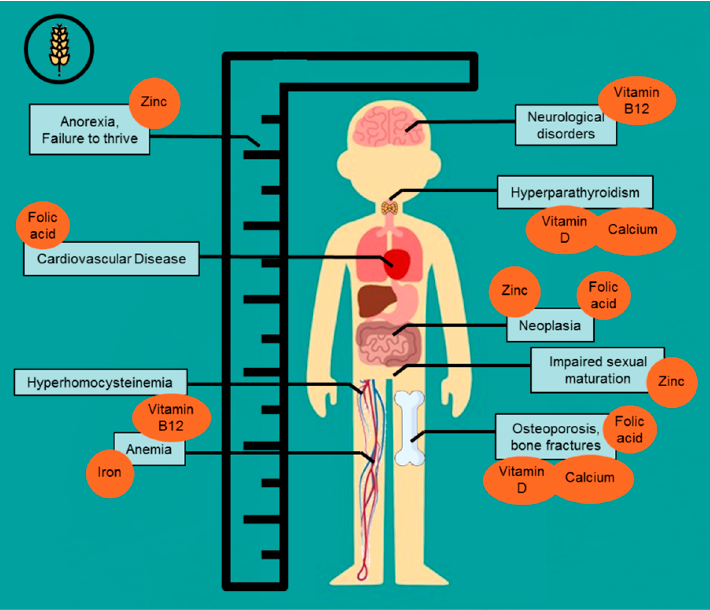
Figure 1. Comorbidities associated with nutrient deficiencies often found in celiac disease.